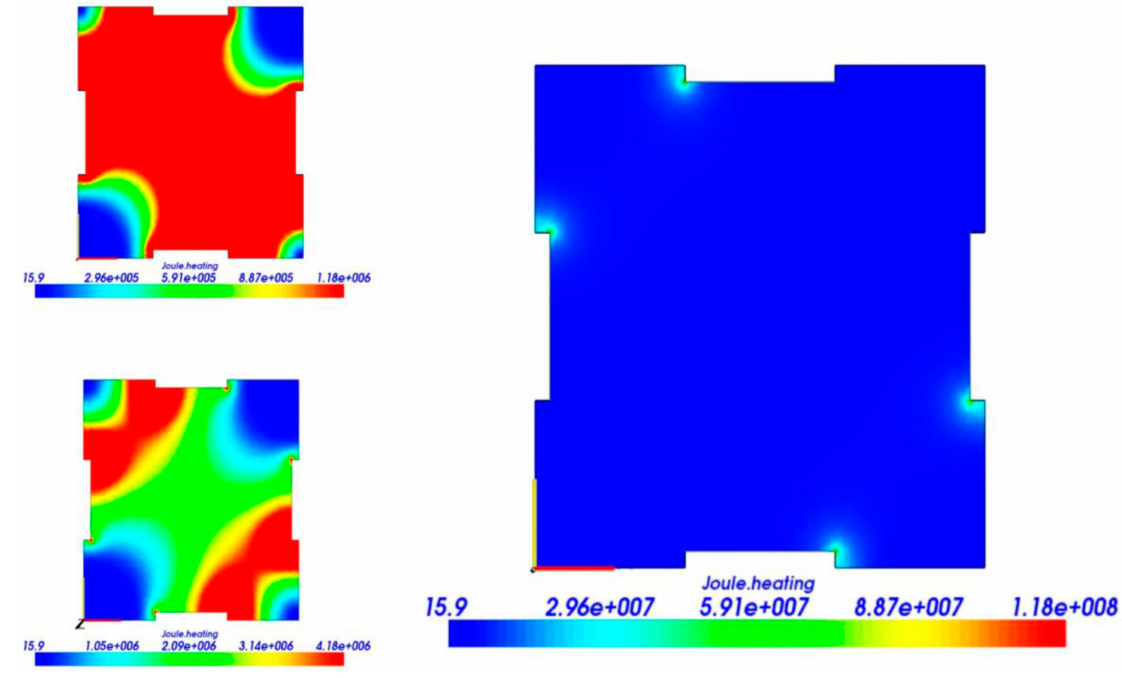
Figure 13. The joule heating distribution